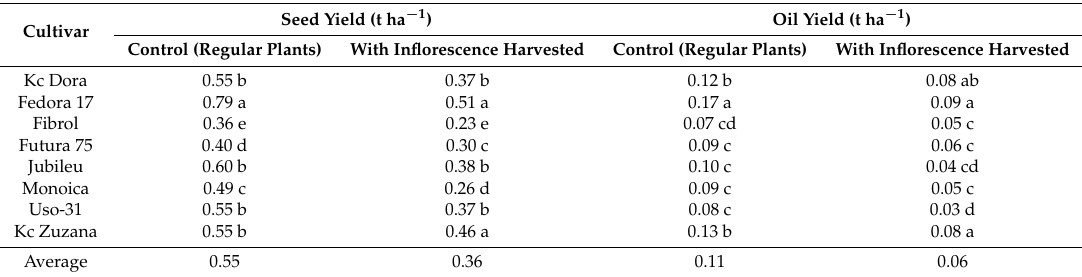
Means within columns followed by different letters are significantly different using the SNK test ( p = 0.05).